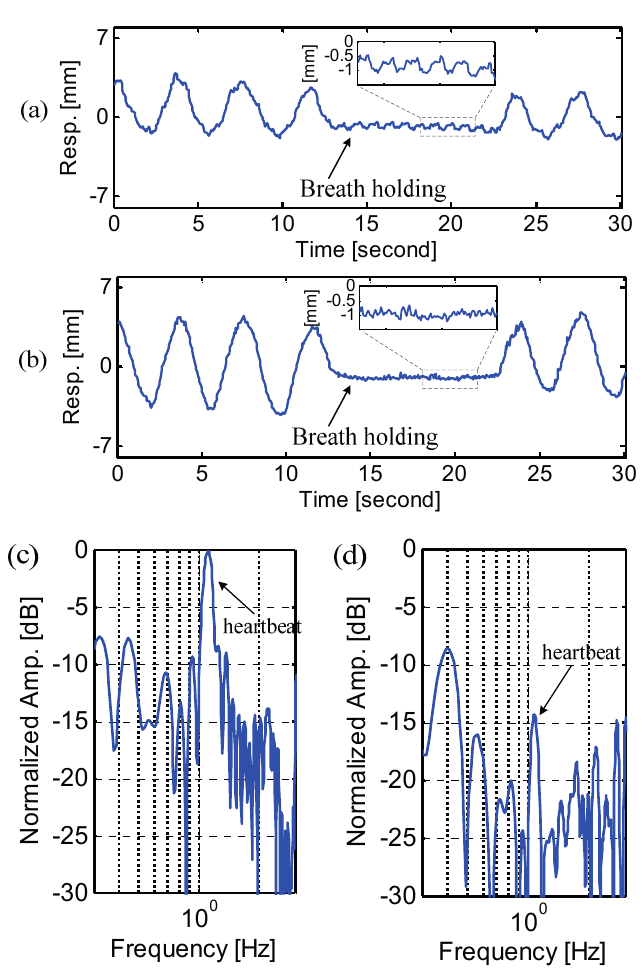
Figure 8. Radar measured respiration patterns from natural breathing to breath holding at ( a ) chest and ( b ) abdomen; ( c , d ) show the spectra of the breath holding at chest and abdomen, respectively.